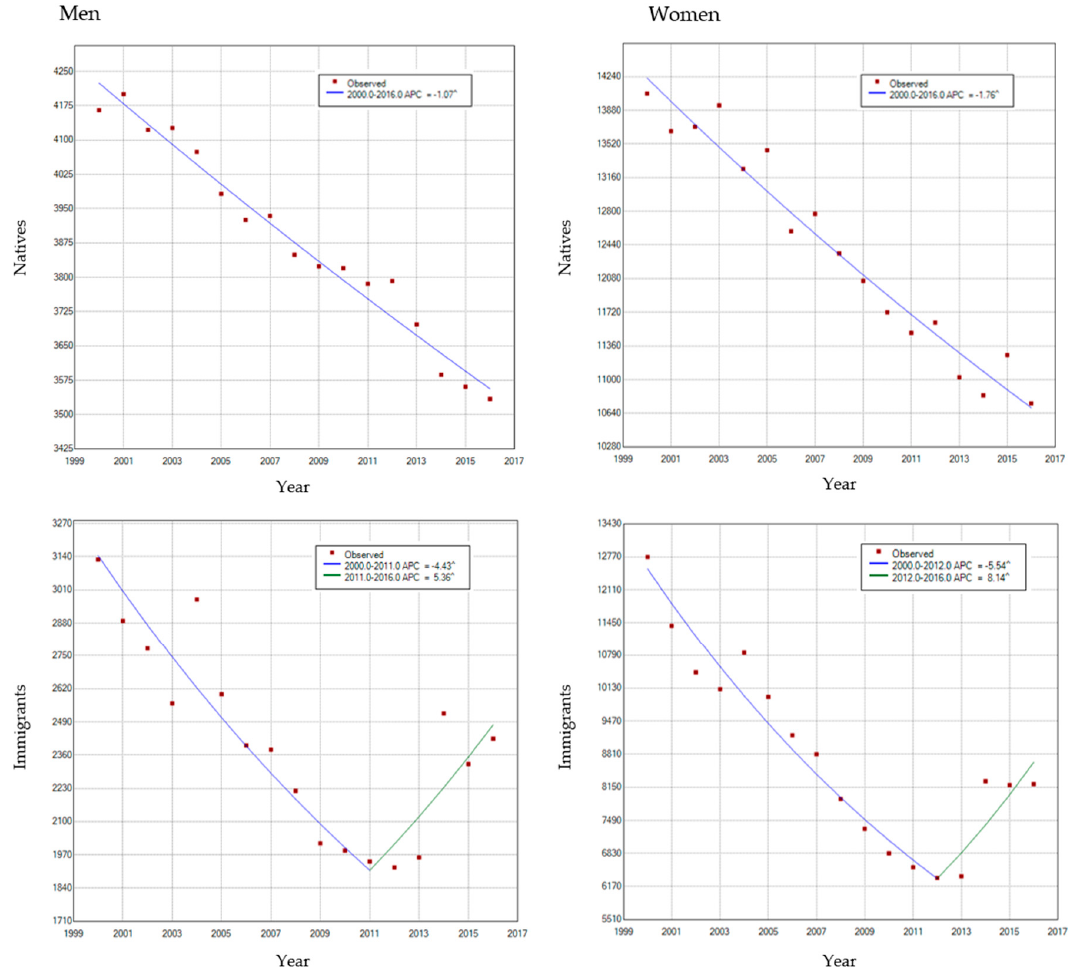
Figure 3. Age-standardized rates of cancer mortality (ASR), Joinpoint, and trends in immigrant and native populations in both sexes, for the period 2000–2016.